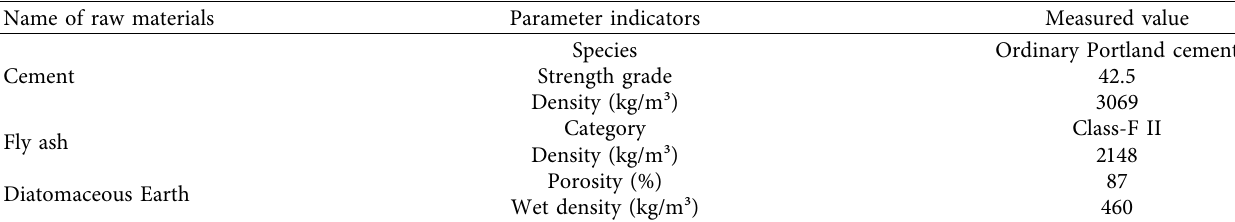
Table 2: Main parameters of foamed concrete raw